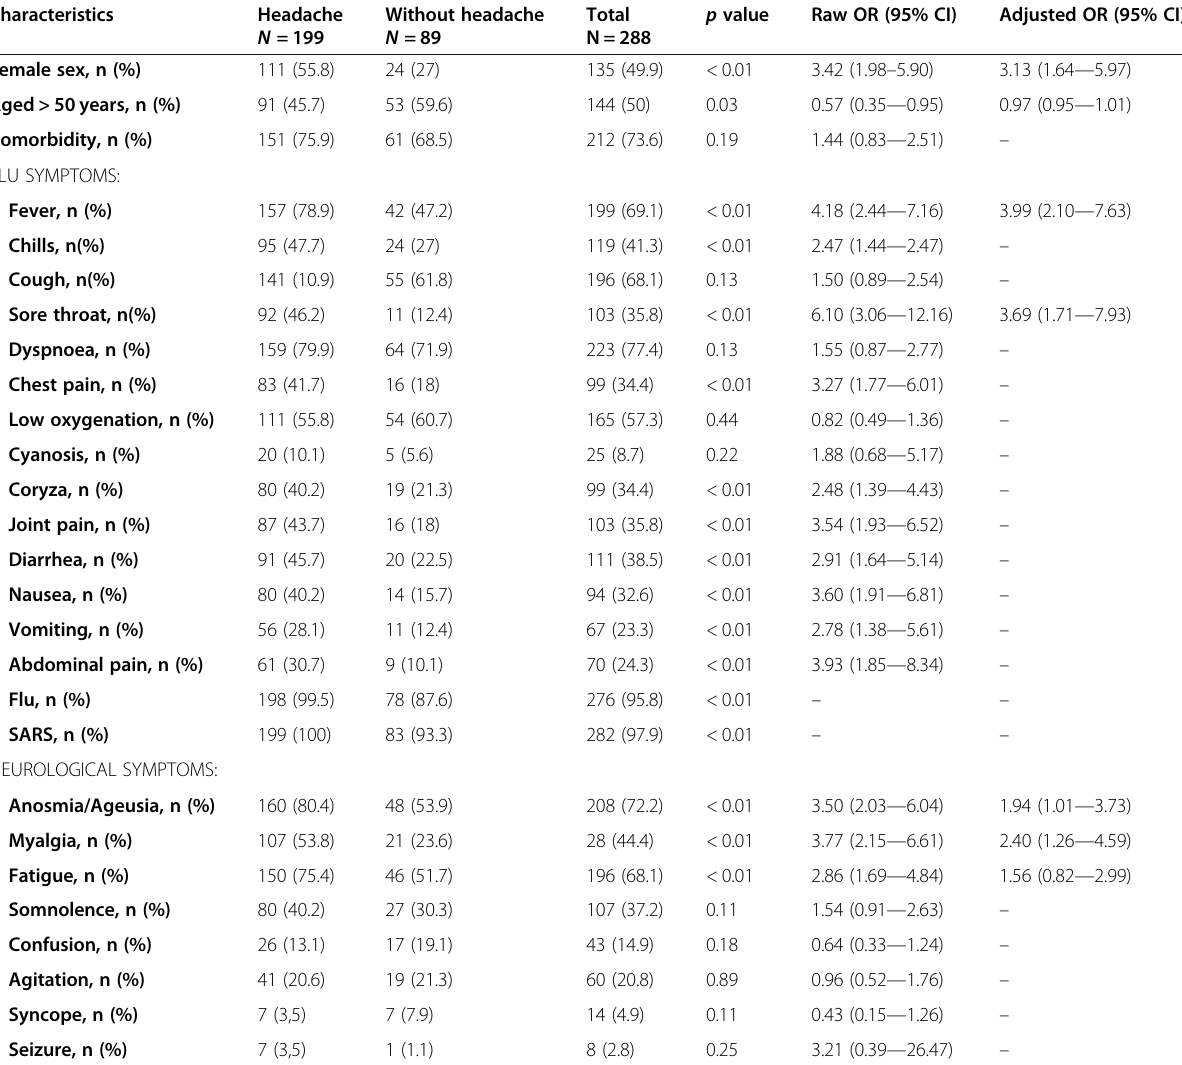
Table 2 Estimated risk for headache according to patient sociodemographic and clinical characteristics